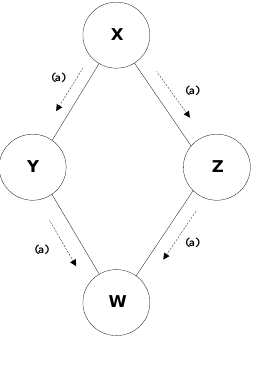
Figure 2. The implosion problem. Node X starts transferring of data (a) to their respected neighboring nodes (Y & Z). Further, data (a) is forwarded from node Y and Z to Node W. At node W, the replicated